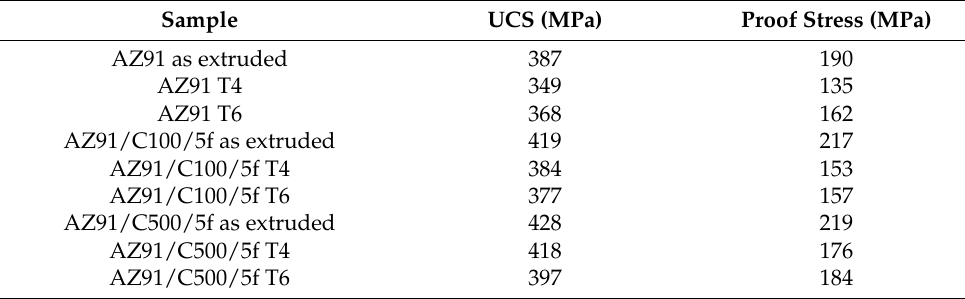
Figure 1. Compression curves showing true stress against true strain of AZ91 ( left ), AZ91/C100/5f ( centre ), and AZ91/C500/5f ( right ). Table 2. Ultimate compressive stress and an estimate of the proof stress of samples (stress for 0.2% yielding). The proof stress was determined graphically using the deformation